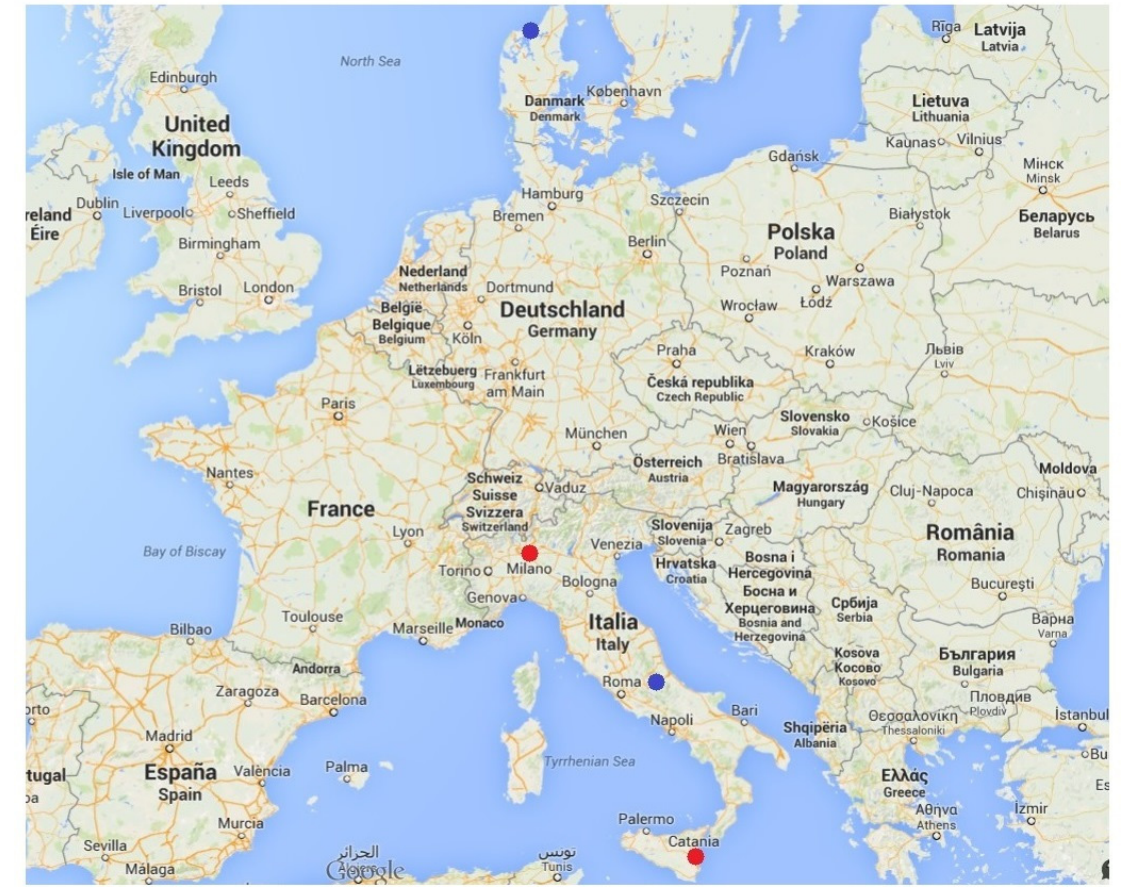
Figure 1. Locations of the wind farms (blue dots) and the PV plants (red